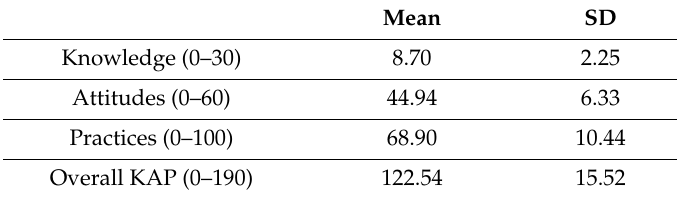
Table 2. Knowledge, attitudes, and practices (KAP) of elderly people related to oral care (n = 385).